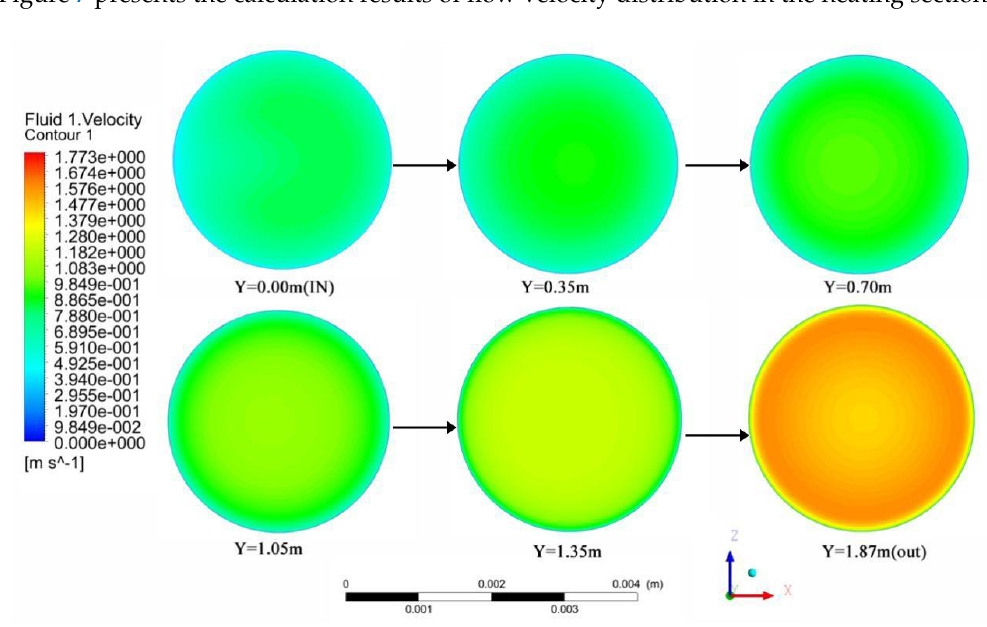
Figure 7. Velocity distribution in the heating section.